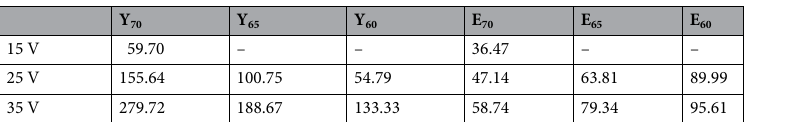
Table 2. Energy consumption and time–space yield by electro-dewatering. Y 70 , Y 65 ,Y 60 were represent time–space yield when water content reach 70, 65 and 60 wt% respectively, unit: kg m −2 h −1 . E 70 , E 65 , E 60 were represent electric energy consumption per tonne sludge when water content reach 70, 65 and 60 wt% respectively, unit: kWh t −1